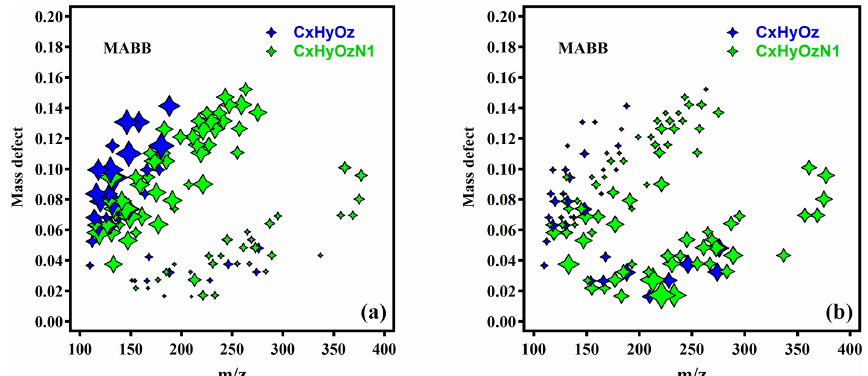
Figure 7. Mass defect plot of factor-specific ions for the MABB EESI factor colored by nitrogen number and sized by H : C ratio (a) and O : C ratio (b) .